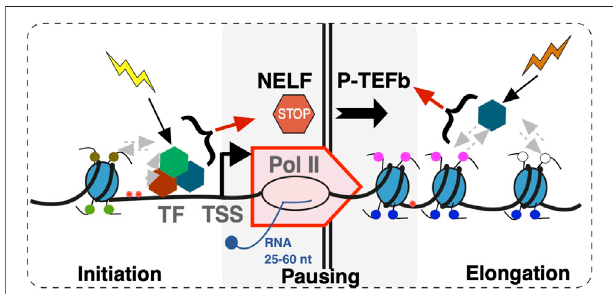
FIGURE 2 | A scheme of events during early transcription elongation. Early transcription elongation within 25 – 60 nucleotides (nt) from the Transcription Start Site (TSS) is a step integrating upstream and downstream regulatory inputs. Upstream inputs from multiple factors including transcription factors (TF) and epigenetic marks result in transcription initiation at the promoter and culminate in NELF-dependent pausing. DSIF complex is not included in the model. Pause release into transcription elongation is dependent on P-TEFb. Uncoupling of transcription initiation and elongation at the site of pausing through mechanisms such as promoter proximal termination contributes to transcriptome